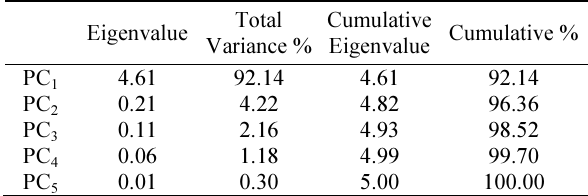
Table 4. Eigenvalue of correlation matrix Eigenvalue